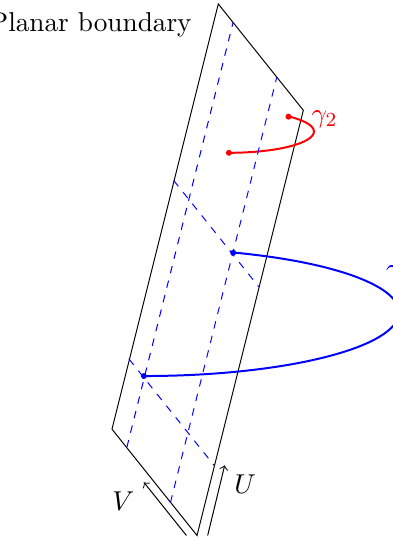
Figure 2 . Various possible relative configurations for the anchor points of HRT surfaces. In the left panel, the U coordinates of the anchors of γ 2 define an interval that is fully contained in the corresponding U interval for γ 1 , while the anchors of γ 3 define a U interval that does not intersect that defined by γ 1 . In such cases the U parts of the HRT-areas commute. The same statements hold with U replaced by V . In contrast, in the right panel the U intervals defined by γ 1 and γ 2 intersect without one being fully contained in the other. In this case the commutator of the U parts of the HRT-areas will not